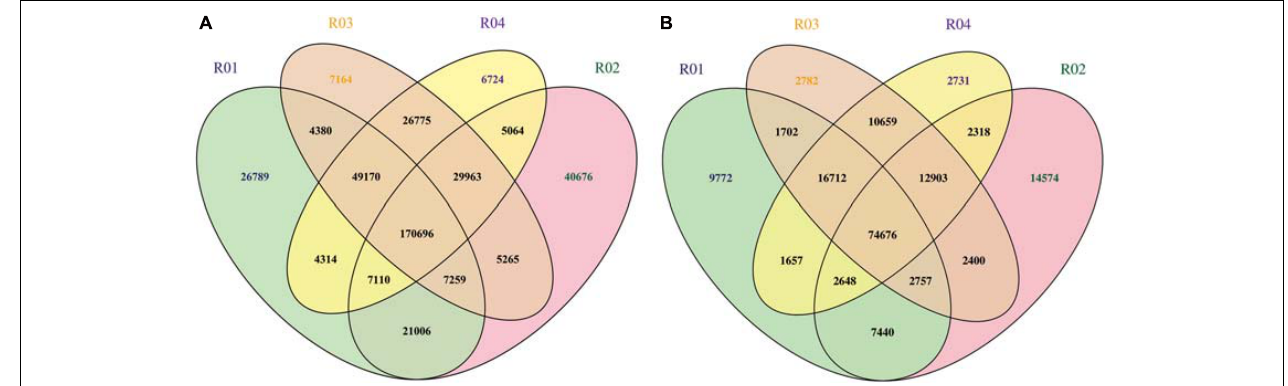
FIGURE 3 | (A) Venn diagram of the SNPs among samples. (B) Venn diagram of the small indels among samples. R01 represents the male parent sample; R02 represents the female parent sample; R03 represents the F 2 generation male-fertile sample; R04 represents the F 2 generation male-sterile sample.